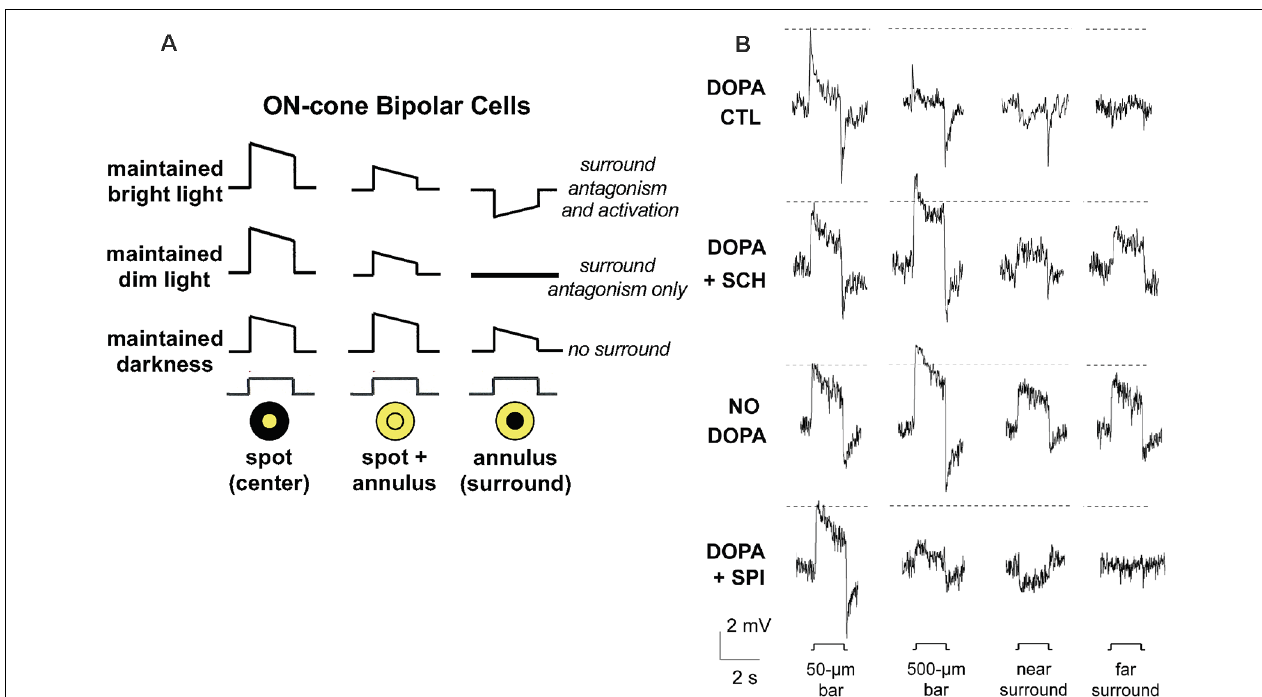
FIGURE 3 | Effect of maintained background light level on receptive field surround of cone bipolar cells (cBCs) is mediated by dopamine D 1 Rs on cBC dendrites. (A) ON-cBC surround antagonism and surround activation are affected by changes in the maintained (30 min) background light level. At all background light levels ON-cBCs produce depolarizing responses to small centered spot stimuli (Column 1). ON-cBCs also produce surround responses that increase in strength and decrease in size as the maintained light level increases. Following maintained bright illumination, surround stimulation in the presence of center stimulation (spot and annulus or ring of light) reduces the center response size of ON-cBCs, a phenomenon known as “surround antagonism.” Also, ON-cBCs produce hyperpolarizing responses to surround stimulation alone (annulus of light) that are opposite in polarity to those produced by center (spot) stimulation alone, a phenomenon known as “surround activation.” Following maintained dim illumination, ON-cBCs exhibit surround antagonism but not activation. Following maintained darkness, ON-cBCs exhibit center responses but minimal surround. HCs (not shown) produce hyperpolarizing responses to all light stimuli at all light levels (i.e., HCs lack surrounds). At all light levels ON-ganglion cell center and surround light responses (not shown) are similar to those of ON-cBCs, but OFF-cBC center and surround responses (not shown) are opposite in polarity to those of ON-cBCs. (B) In whole cell patch clamp recordings from ON cBCs in dark-adapted rabbit retinal slices superfused with Ames medium containing dopamine (5 µ M) to mimic the effect of maintained (30 min) bright illumination, ON-cBCs (top row-control, DOPA CTL) exhibited both surround antagonism (i.e., the amplitude of center responses was reduced by simultaneous surround stimulation, as occurred in response to 500- µ m (center